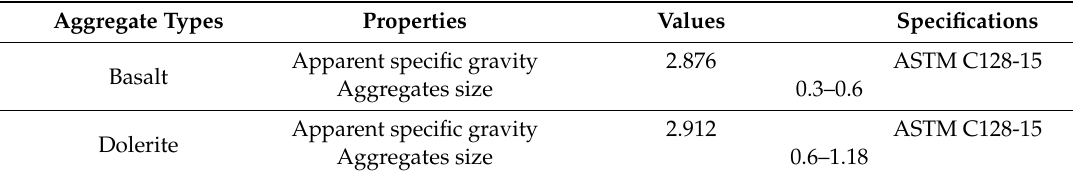
Table 3. Characteristics of fine aggregates for antiskid surface